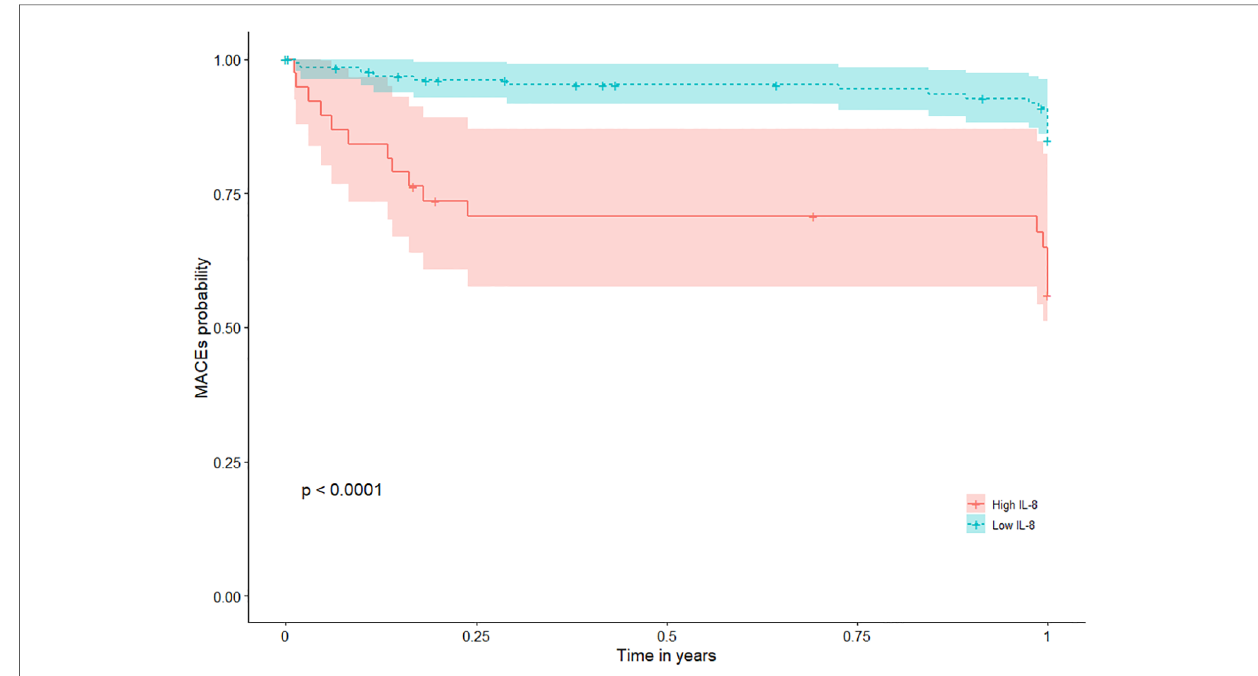
FIGURE 2 MACEs according to IL-8 Levels in patients with MI during 1-year follow-up. Kaplan-Meier plots of MACEs during 1-year follow-up according to high (greater than the cutoff value 32.5 pg/ml) or low IL-8 (less than or equal to 32.5 pg/ml). IL-8 was measured after a 12-h overnight fast on the second day of admission of CCU. CCU, coronary care unit; IL, interleukin; MACEs, major adverse cardiovascular events; MI, myocardial infarction; sIL-2R, soluble IL-2